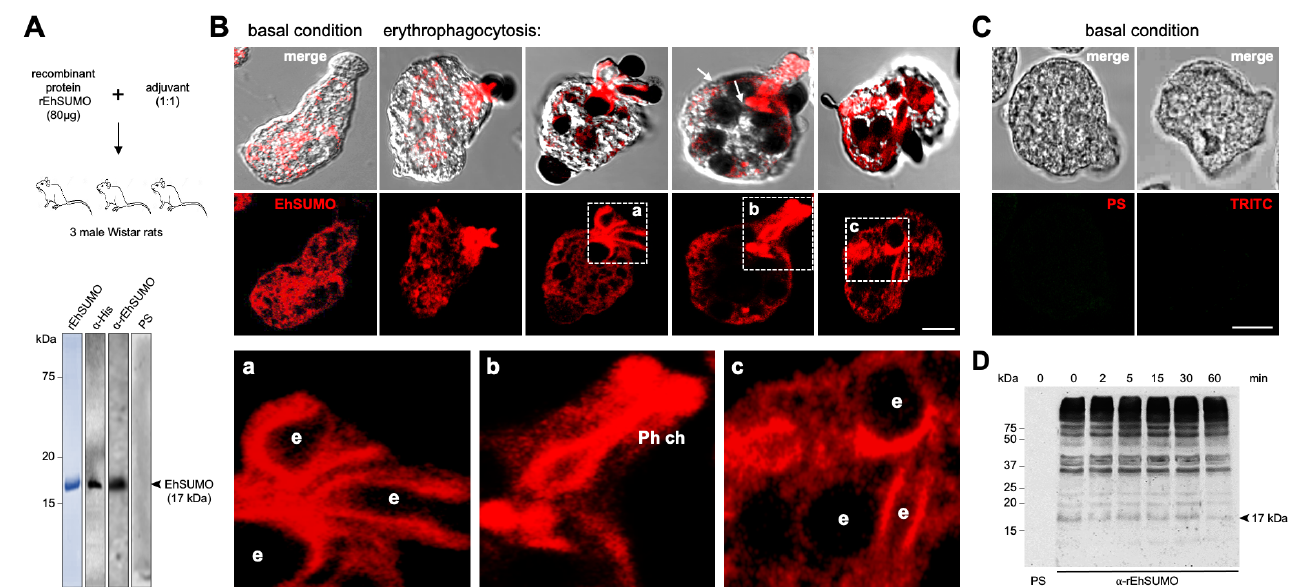
Figure 5. Cellular location of EhSUMO during phagocytosis. ( A ) Immunization scheme to produce α -EhSUMO antibodies, probed in western blot assays, using bacterial lysates. α -His antibody: positive control. Pre-immune serum (PS): negative control. Lane 1: rEhSUMO stained with Coomassie blue. Numbers at left: molecular weight standards. ( B ) Confocal microscopy of trophozoites in basal condition and after erythrophagocytosis, using α -EhSUMO antibodies. Squares: different structures formed during phagocytosis magnified in ( a – c ). ( a ) Structure with the form of a conduit or channel. ( b ) Phagocytic channel (Ph ch). ( c ) The elongated structure surrounding a phagocytosed erythrocyte. e: erythrocytes. Scale bar = 10 µ m. ( C ) Negative controls: trophozoites in basal conditions incubated with PS or only with the secondary antibody (TRITC). ( D ) Western blot analysis of trophozoites lysate in basal condition (0 min) and after erythrophagocytosis, using PS or α -EhSUMO antibodies. Number at left: molecular weight